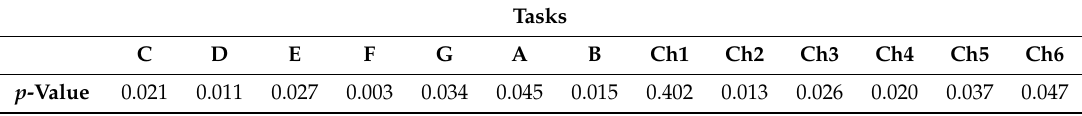
Table 3. Welch t-test for Task 1 (playing individual chords) and Task 2 (playing chord transitions).